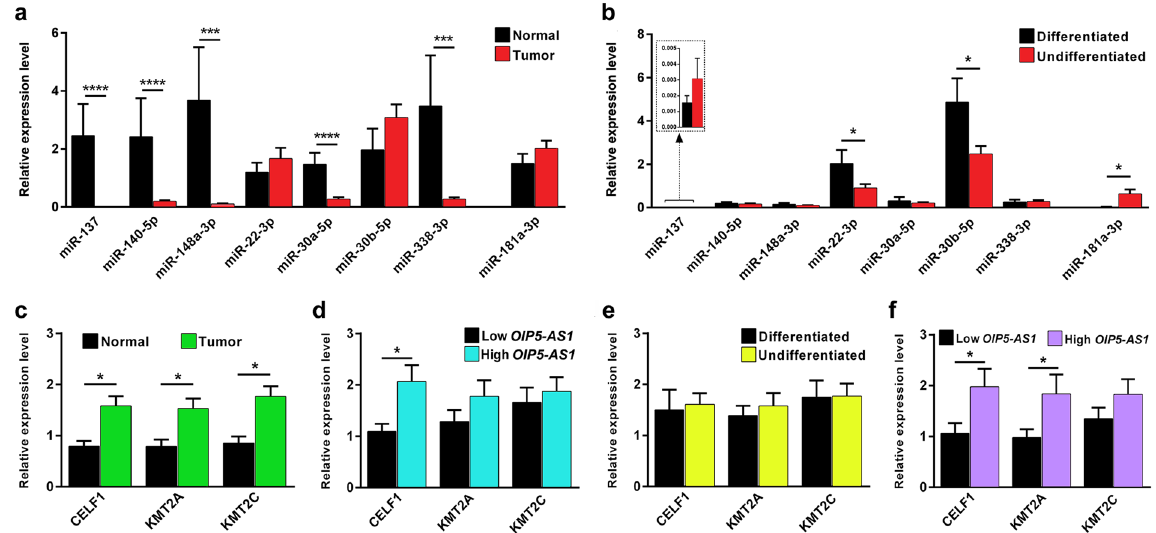
Figure 3. Expression profiling of predicted miRNAs and their downstream target genes. ( a ) Expression levels of predicted miRNAs in oral tumors and normal tissues. Except for miR-22-3p and miR-30b-5p, other miRNAs are significantly downregulated in oral tumors. ( b ) Expression levels of predicted miRNAs in oral tumors between cell differentiation status. miR-137 which shares the least common downstream target and miR-181a-3p which don’t have interaction site with OIP5-AS1 and nor seed match for stemness TFs was upregulated in undifferentiated oral tumors. ( c ) Expression of CELF1, KMT2A and KMT2C were significantly overexpressed in oral tumor compared with normal tissues. ( d ) Expression levels of CELF1, KMT2A and KMT2C in oral tumors that overexpressed OIP5-AS1 compared to OIP5-AS1 low expressed tumors. All the 3 mRNAs were upregulated in OIP5-AS1 overexpressed oral tumors with CELF1 having statistical significance. ( e ) CELF1, KMT2A and KMT2C were overexpressed in oral tumors with undifferentiated cellular pathology. ( f ) Undifferentiated oral tumors with high levels of OIP5-AS1 also upregulated CELF1, KMT2A and KMT2C compared with undifferentiated tumors with low OIP5-AS1 . CELF1 and KMT2A which has the maximum number of predicted miRNAs binding overexpressed significantly than the KMT2C with the minimum number of predicted miRNAs binding. Statistical significance represented as ** for P < 0.01, *** for P < 0.001 and **** for P < 0.0001 (two-tailed Student’s